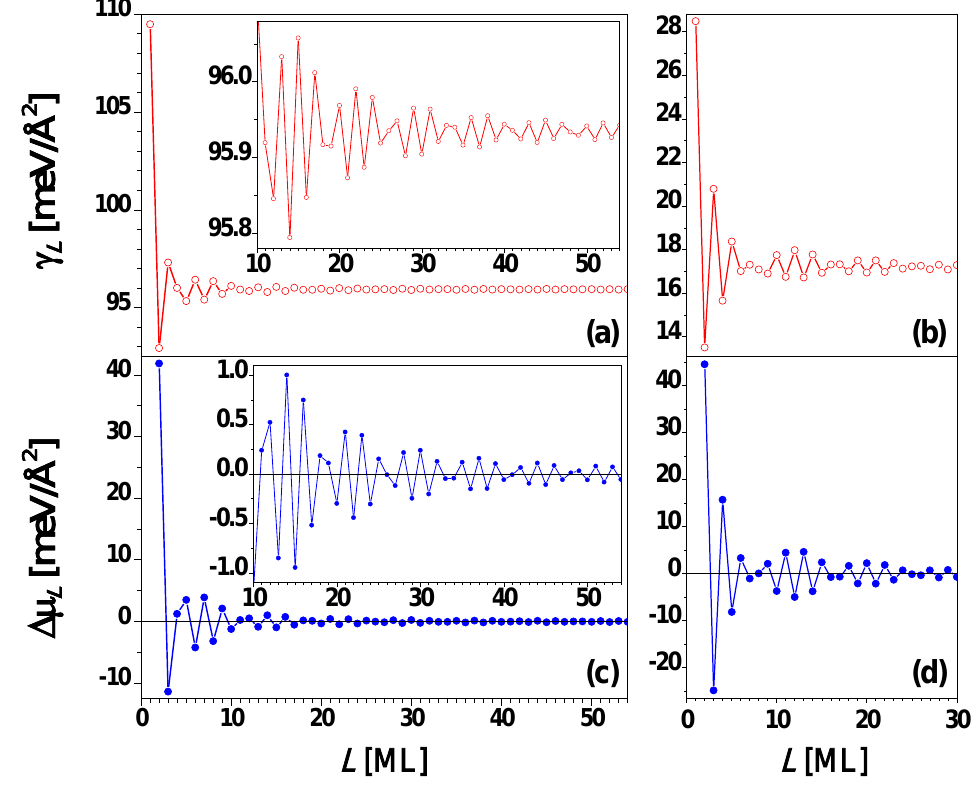
Figure 4. Surface free energy γ versus thickness L for a freestanding Pb(111) nanofilm L from (a) EGM and (b) DFT calculations, respectively. Stability index ∆µ versus L from L (c) EGM and (d) DFT calculations, respectively. The insets are the corresponding local enlargement. From [67] (Copyright American Physical Society